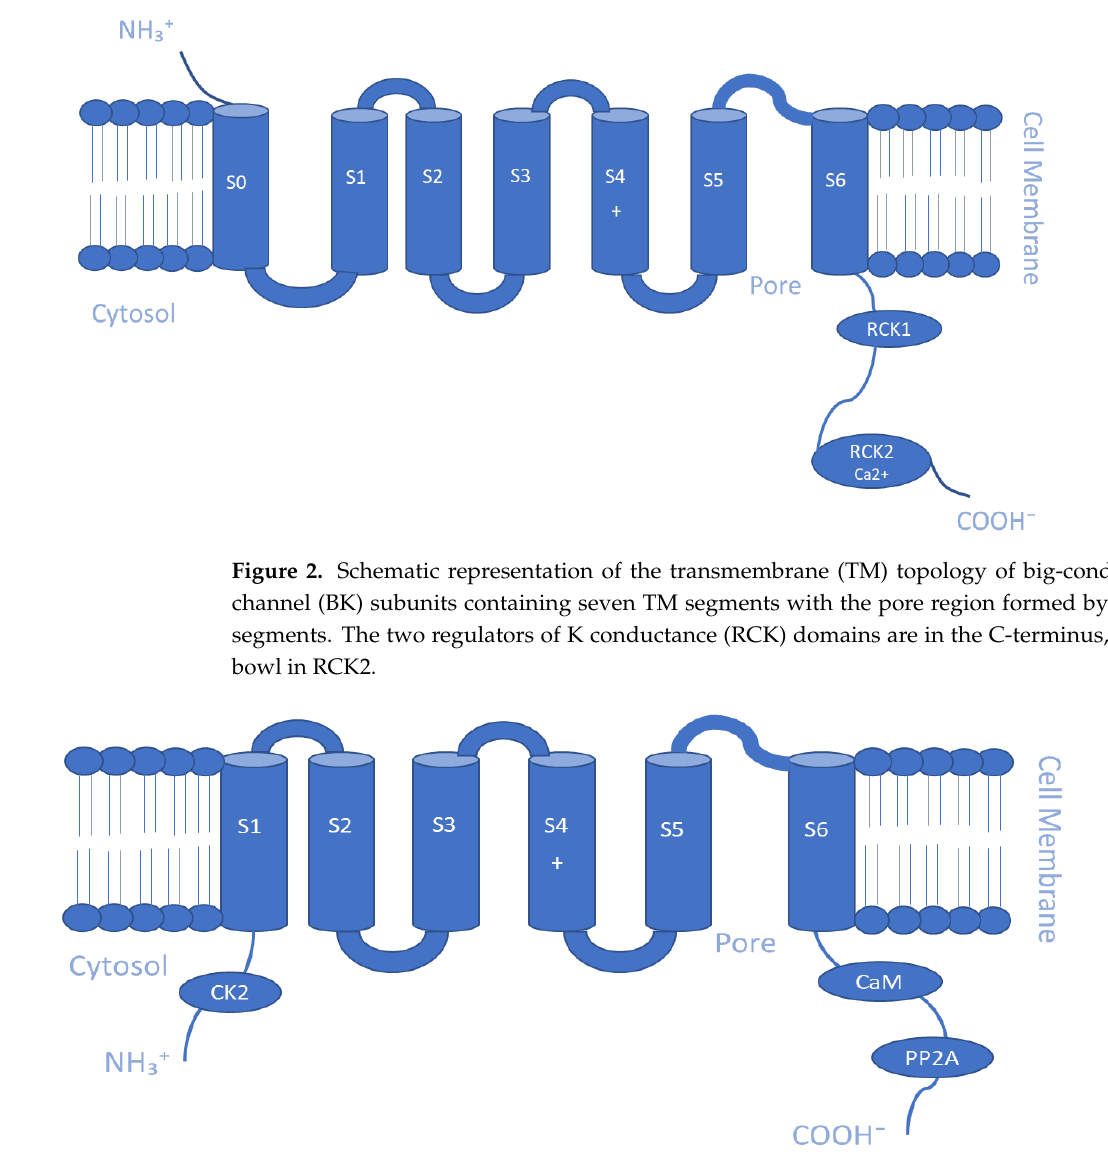
Figure 3. Schematic representation of the transmembrane (TM) topology of small-conductance K channel (SK) subunits containing six TM segments with the pore region formed by S5 and S6 seg- ments. The regulators involve calmodulin and PP2A in the C-terminus and CK2 in the N-terminus.